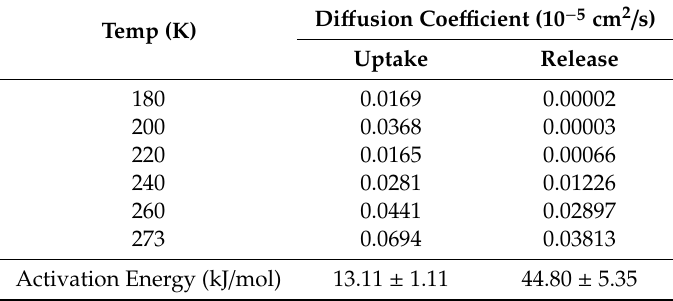
Table 1. The di ff usion coe ffi cient and the activation energy of the hydrogen molecules in hydrate cages Table 1. The diffusion coefficient and the activation energy of the hydrogen molecules in hydrate at various temperatures for both uptake and release simulation cages at various temperatures for both uptake and release simulation studies.